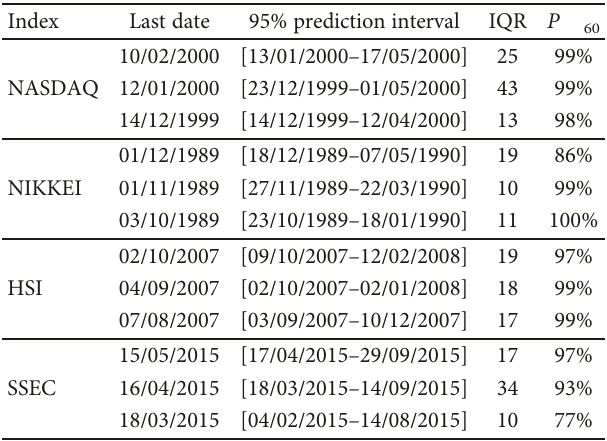
Table 3: Summary of predicted critical times. The last date is divided into three di ff erent groups, which are from one to three months before the actual critical